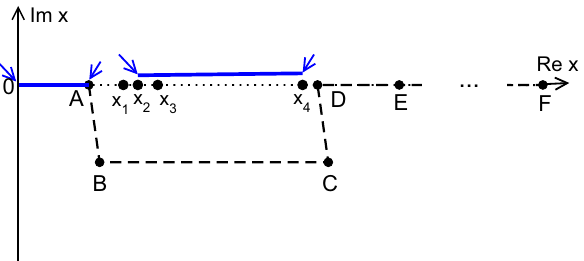
Fig. 1 Branch points (blue arrows) and cuts (solid blue) of the Kacser function κ( M 2 , M 2 π , x ) , and integration paths. We connect the branch points with cuts in the intervals [ 0 , 4 M 2 π ] and [ ( M − M π ) 2 ,( M + M π ) 2 ) ] . The original path of integration for the dispersive